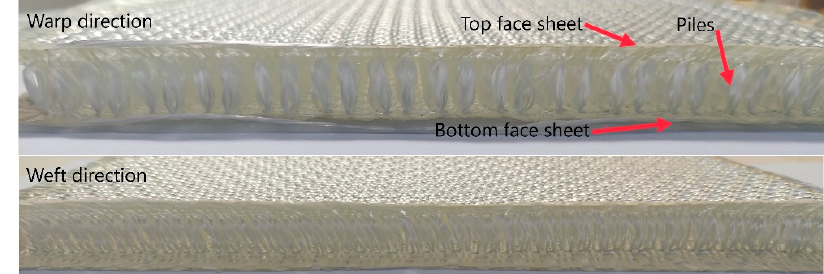
Figure 1. “8” shaped woven spacer